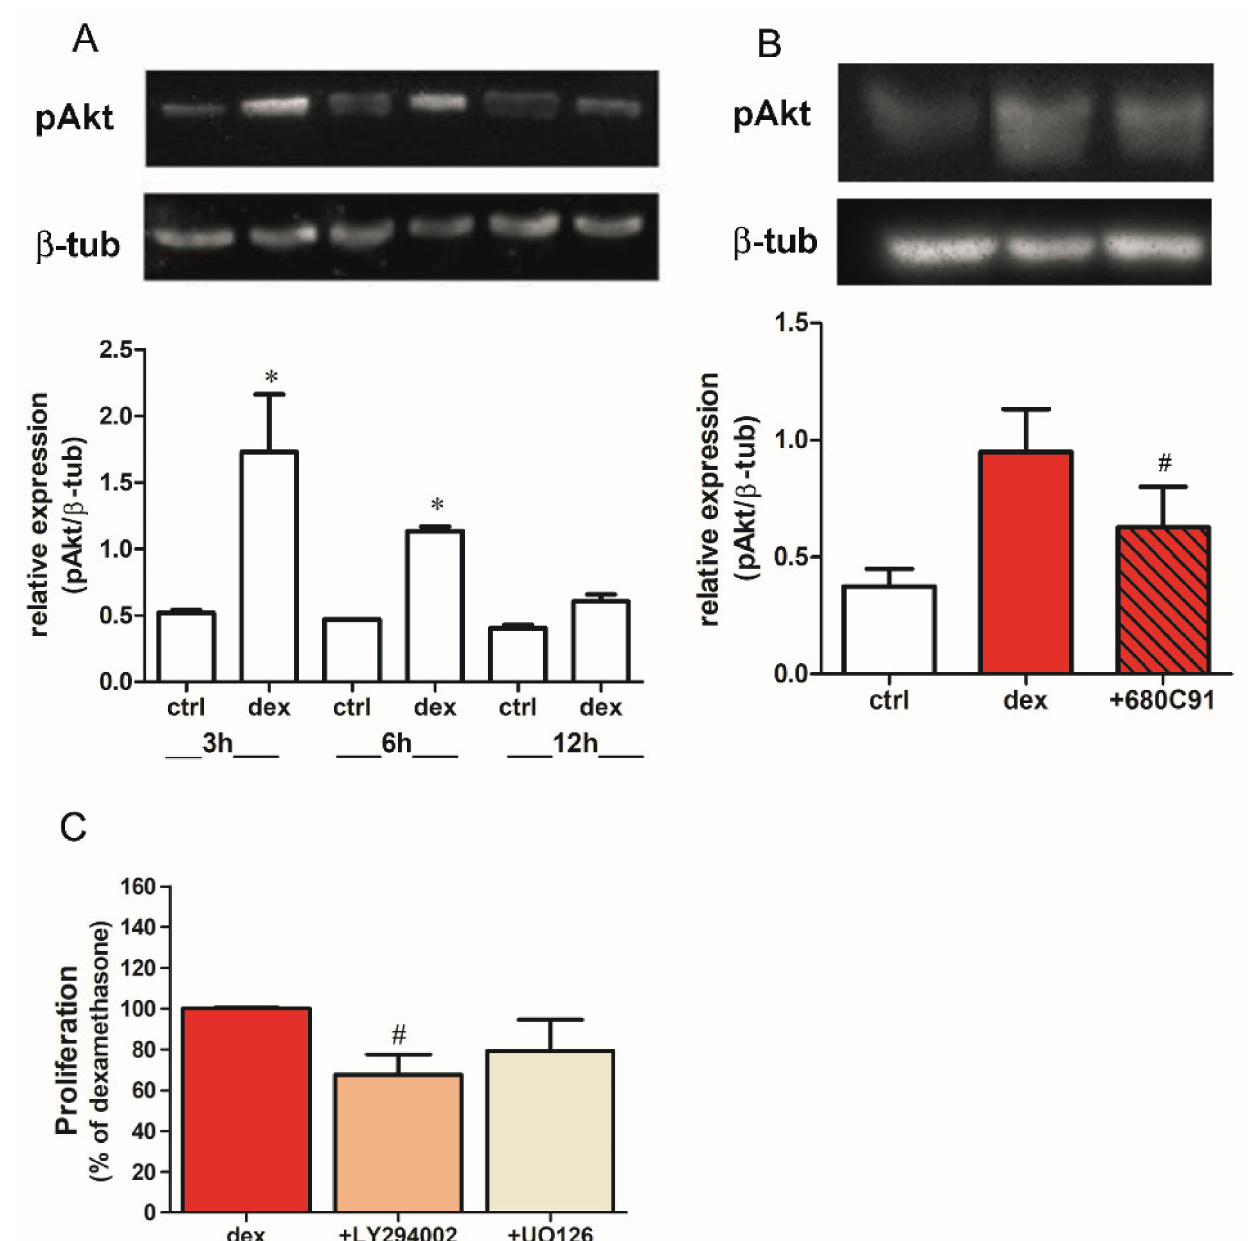
Figure 6. Dex activates Akt in SK-Mel-28 cells. ( A ) Cells were treated with dex for different durations (3, 6, or 12 h). Western blotting for phosphorylated Akt and β -tubulin. ( B ) Cells were stimulated with 25 µ M dex alone (dex) or in presence of 40 µ M 680C91 (+680C91) for 3 h (* p < 0.05, vs. ctrl; # p < 0.05 vs. dex alone). ( C ) Cells were treated with dex alone (dex) or co-treated with LY294002 (5 µ M) or U0126 (10 µ M), Akt and MEK inhibitors, respectively, and proliferation assessed. Data are plotted as mean ± SE ( n = 3; # p < 0.05, vs. dex